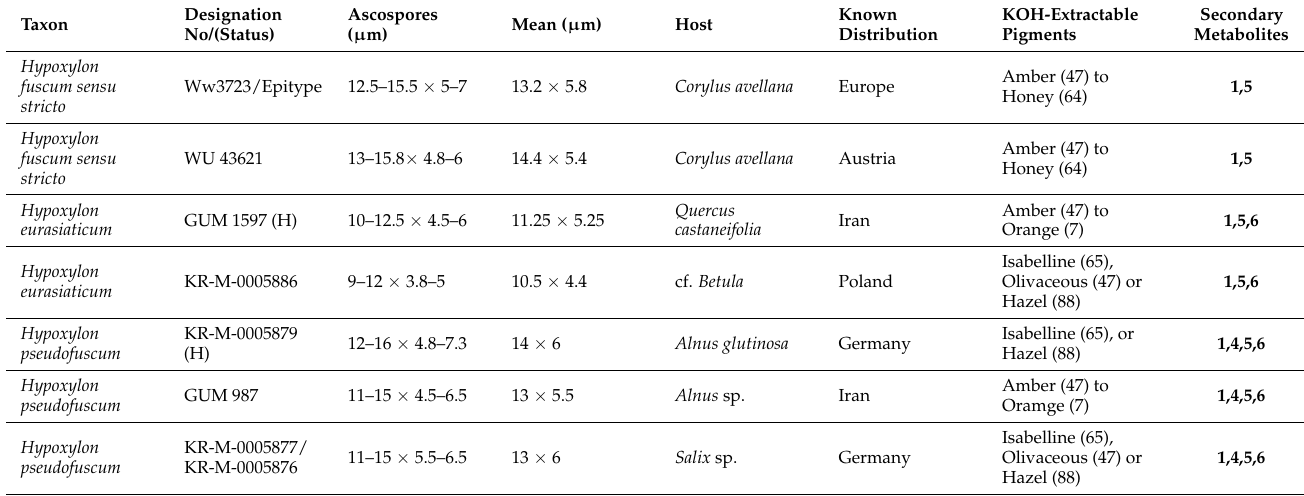
Table 2. Diagnostic characters of the Hypoxylon fuscum complex.